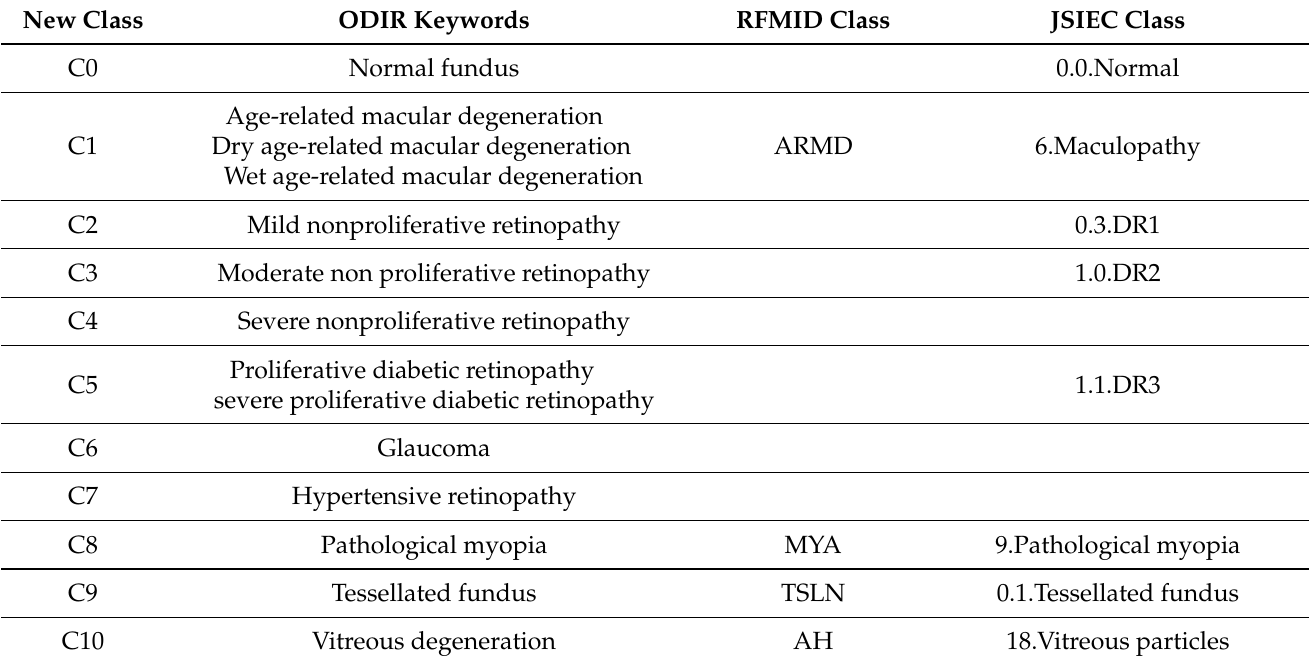
Table 2. Mapping rules for combining ODIR, RFMID, and JSIEC into 39 classes (C0–C38). Classes indicated with Gray have been removed since they contain too few instances ( <